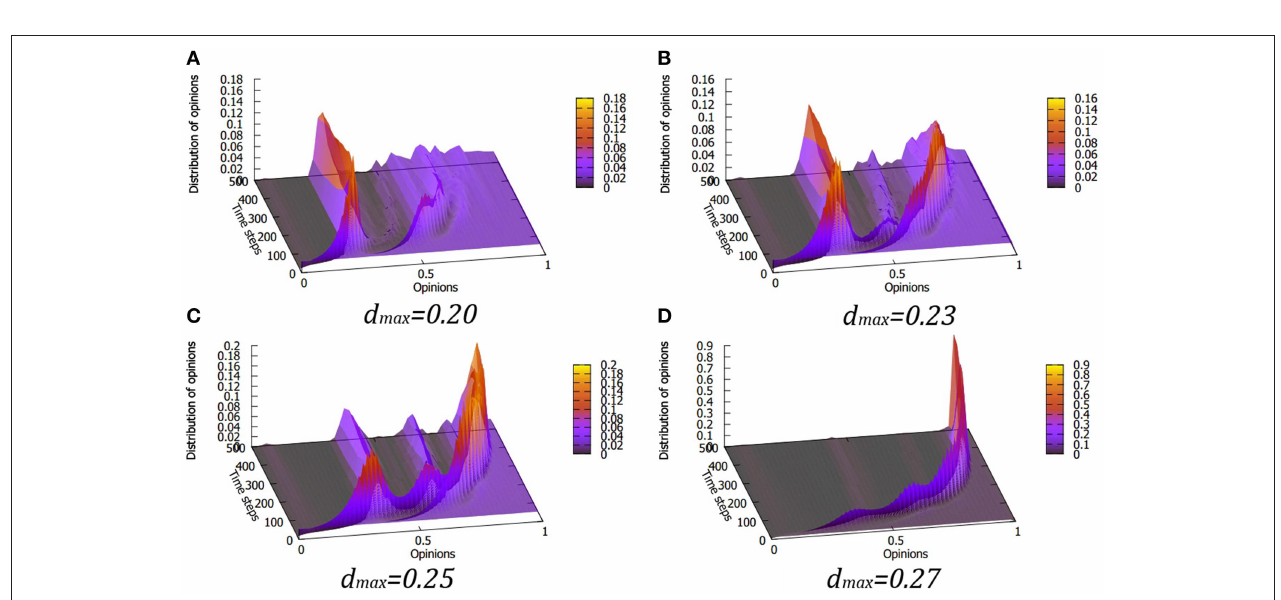
FIGURE 6 | Evolution of opinion distribution for various values of the maximum tolerance d max for the quadratic form of the Equation (5), i.e., L = 2 and the mood factor m = 0 . 5 . Panels (A–D) correspond to d max values of 0.20, 0.23, 0.25 and 0.27, respectively.